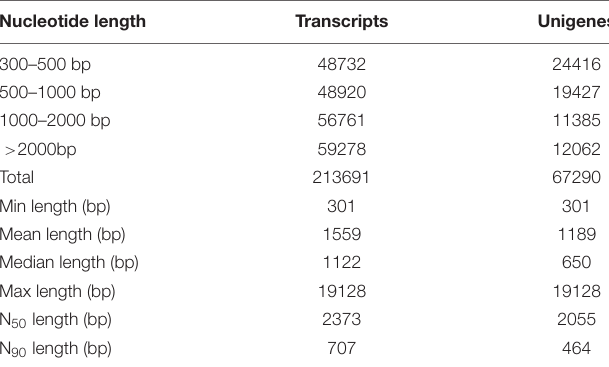
TABLE 1 | Statistical analysis of length distribution of transcripts and